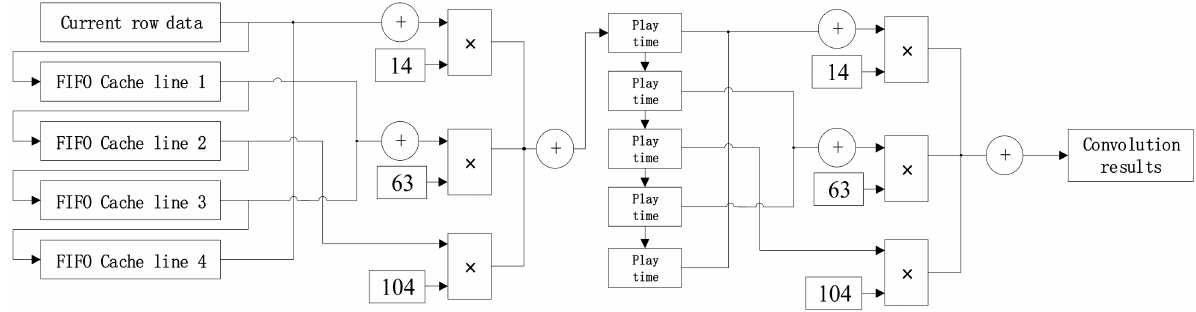
Figure 4. Calculation circuit module of Gaussian filtering.